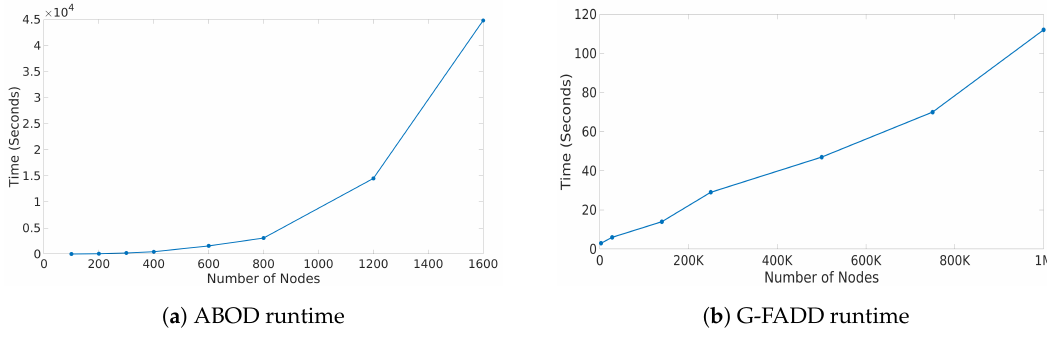
Figure 3. Scalability of ABOD and G-FADD for varying graph size. x -axis: number of nodes; y -axis: runtime in